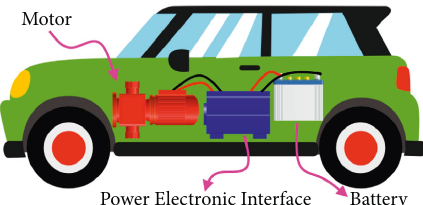
Figure 3: Hybrid electric vehicle.